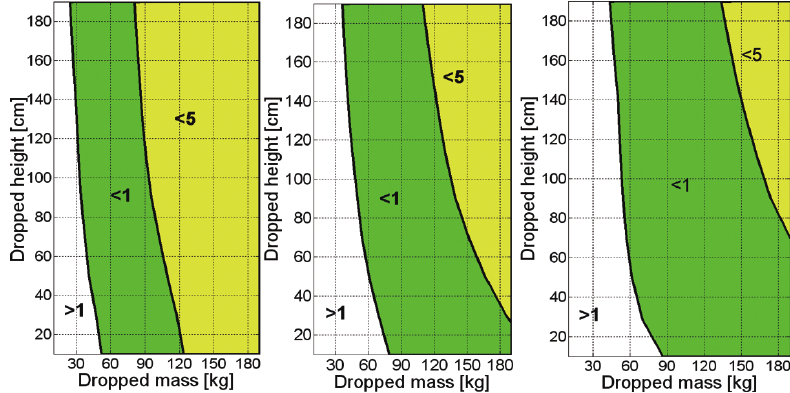
Fig. 7. Ratio of maximal forces in two stages of the process in dependence on the impact mass and velocity for different initial pressures: 20 kPa (left), 200 kPa (middle), 400 kPa